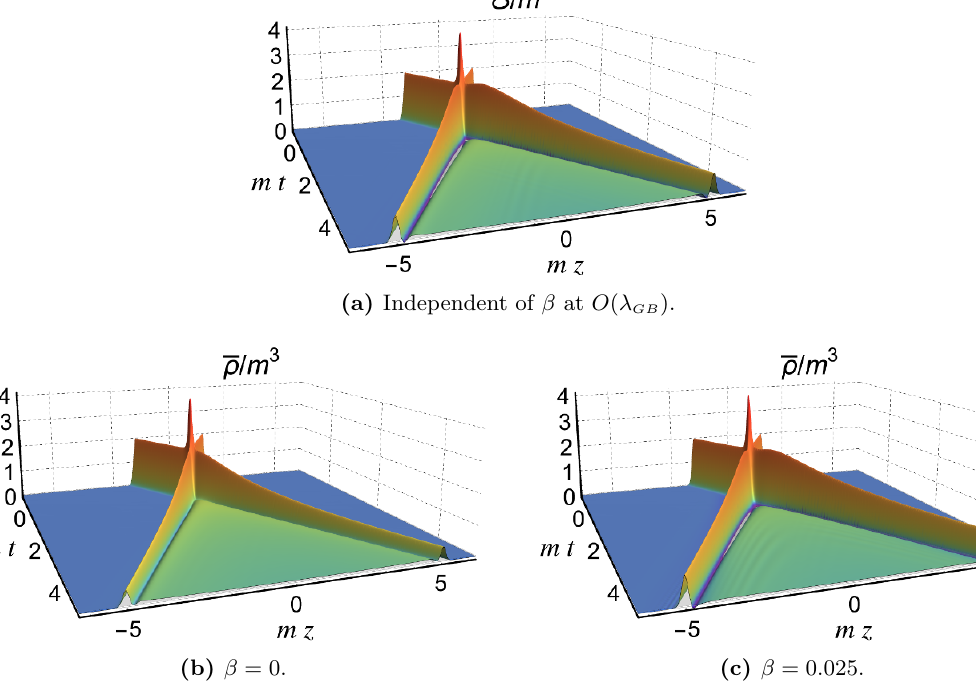
Figure 2 . Spacetime dynamics of the energy density (top panel) and baryon number density (bottom panels) in collisions of thin sheets (width w = 0 : 1 =m ) at (cid:21) The lower panels are at two di(cid:11)erent values of (cid:12) .